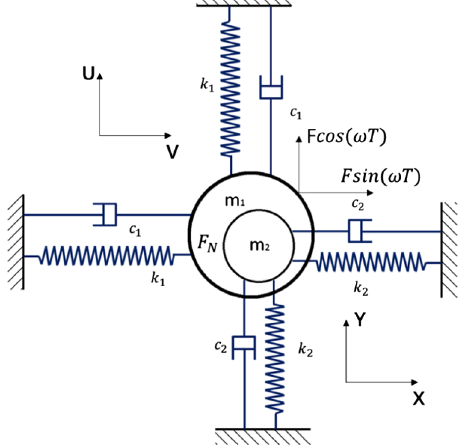
FIG. 2. Equivalent spring-mass model of a QWR installed with a damper.